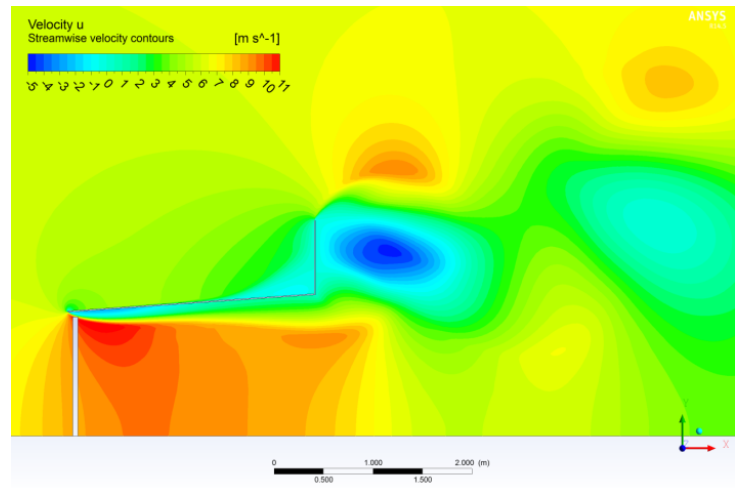
Figure 9: Velocity contour plot of flow through DAWT, D = 2.5 mm, L = D, h = 0.3D, 2 α = 8°.